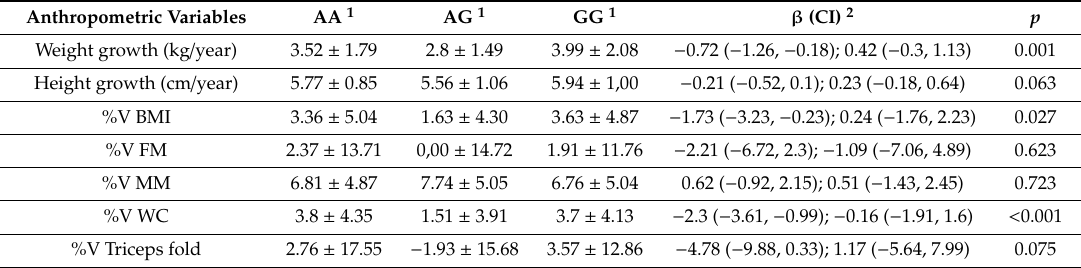
Table 1. Average anthropometric change by genotype, and the association identified between these variables and the presence of the Q223R LEPR single nucleotide polymorphism (SNP).